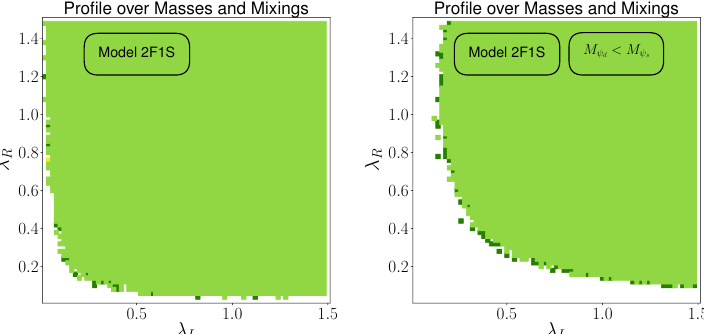
Figure 14. Viable points in the λ L − λ R plane obtained from scanning over the masses of the new scalar and fermions between 0 and 5000 GeV, as well as the Yukawa couplings λ [0 , 1 . 5] and L,R ∈ λ 1 , 2 ∈ [0 , 3 . 5] for Model 2F1S. Colours are the same as in figure 9. Scan targeted the observed value of the dark matter relic density 0 . 1200 , eq. (1.8), the a value in eq. (1.6), and the direct detection µ log likelihood provided by DDCalc [508], where points which are excluded by direct detection limits or are more than 3 σ away from the Planck observation are thrown